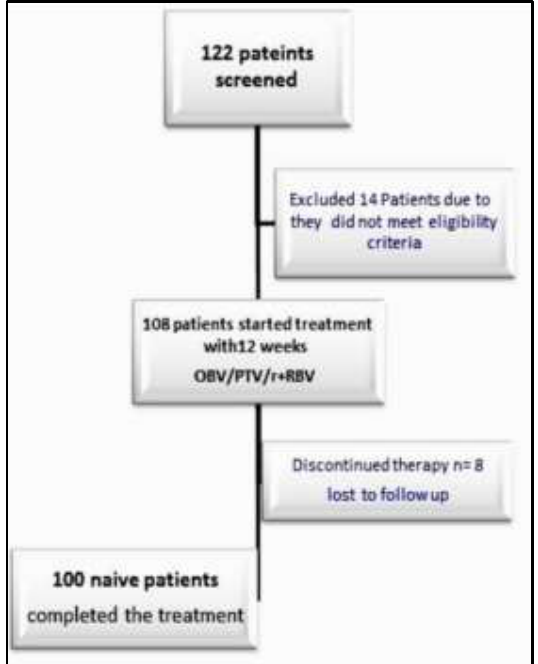
Figure. 1 Patients disposition and the study design. OBV; ombitasvir, PTV; paritaprevir, r; ritonavir. RBV;